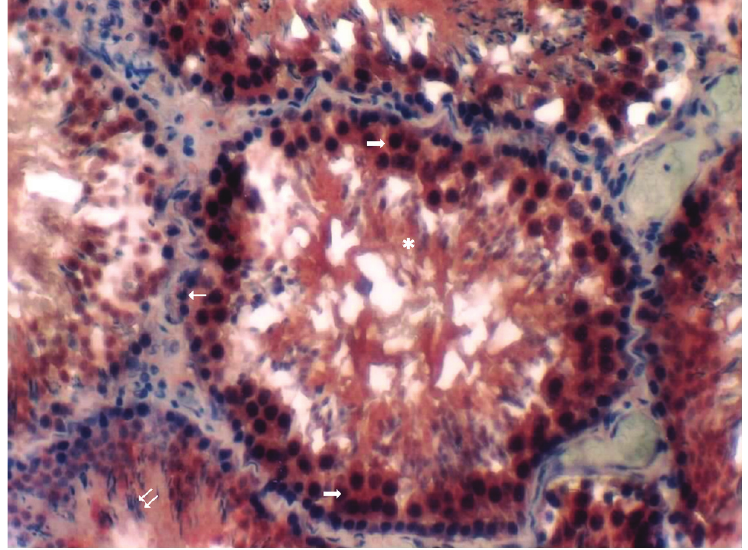
Figure 1. Total body irradiation group (morning). Asterisk: Degenerative seminifer- ous tubules; thin horizontal arrow: weak-to-moderate immunoreactivity in the sper- matogonia; thick horizontal arrows: primary spermatocytes displaying moderate-to- strong immunoreactivity; double oblique arrows: weak spermatid immunoreactivity (immunoperoxidase and hematoxylin staining,